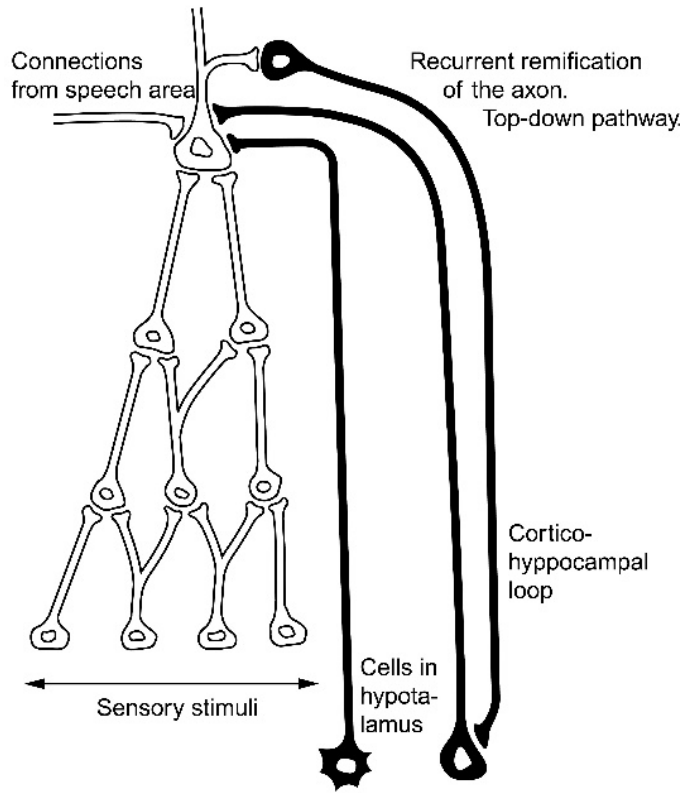
Figure 2. There are three types of connections with the object neurons. Considering the neuronal structure that is active during the perception of a certain object, the connections from the side of the hypothalamus and amygdale, which are active at the time of learning, should be distinguished from connections from the side of the hippocampus where are the elements of the working memory system. Excitation of the object neuron from the side of the speech area is sustained by the cortico- hippocampal loops of the working memory system.